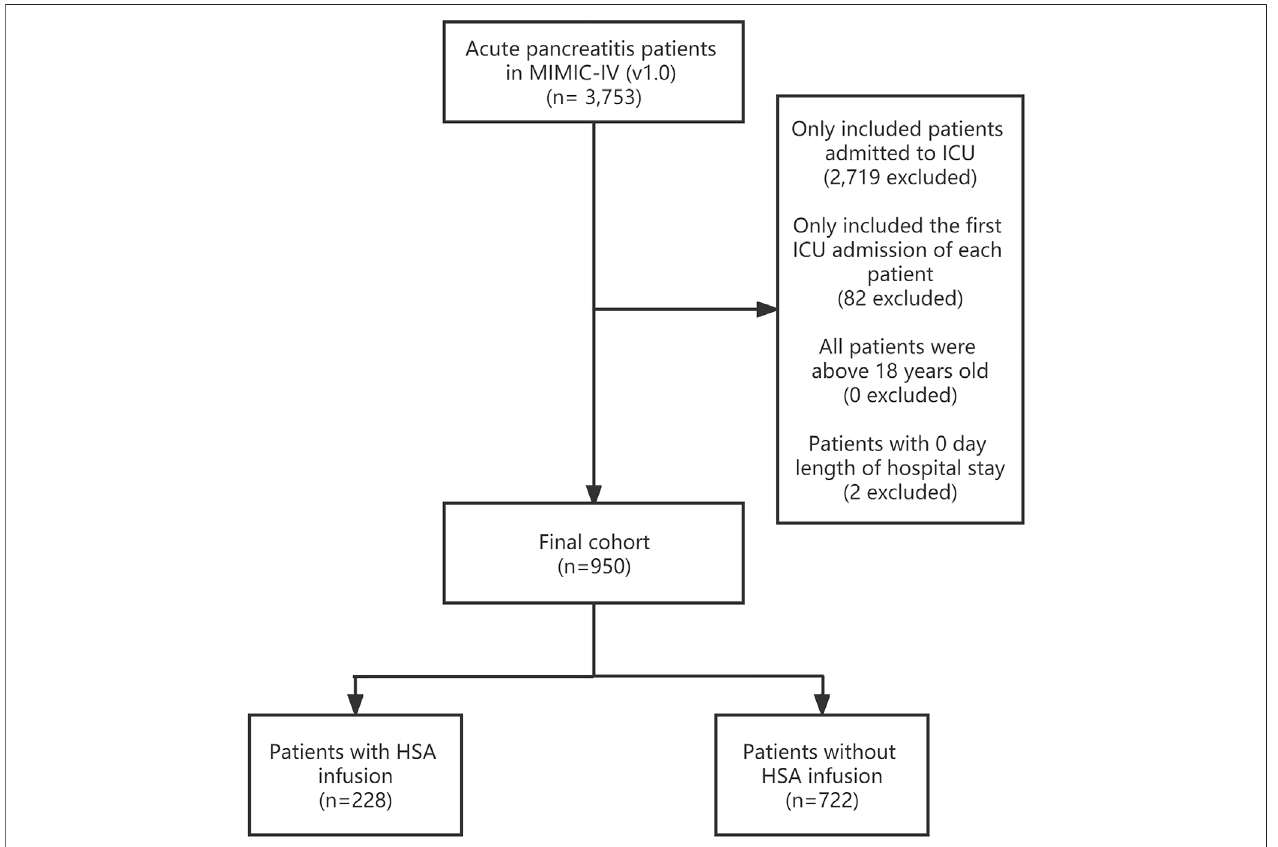
FIGURE1| Studysamplescreeningprocessof950acutepancreatitispatientsfromtheMIMIC-IV database.ICU,intensivecareunit;HSA,humanserumalbumin.